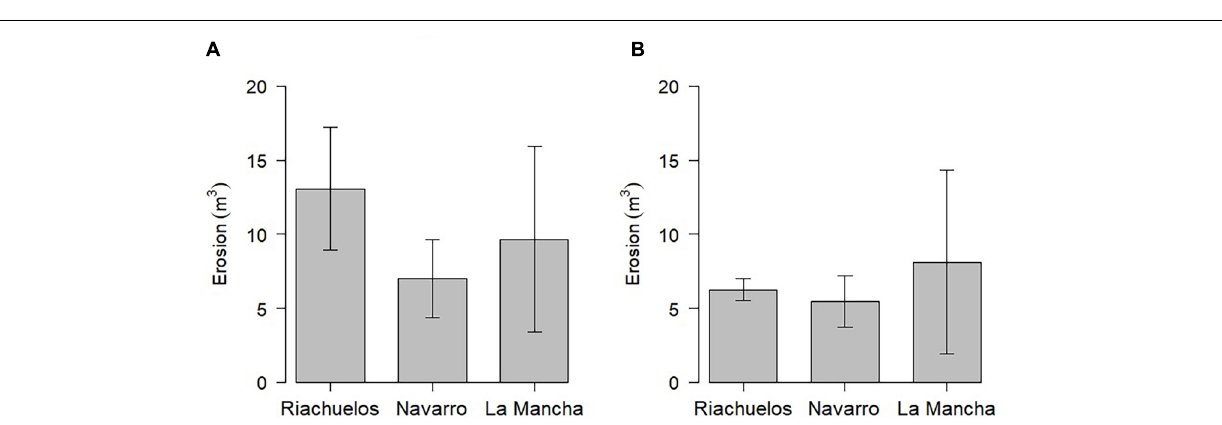
absent before it, were Parthenium hysterophorus, Macroptilium atropurpureum and C.